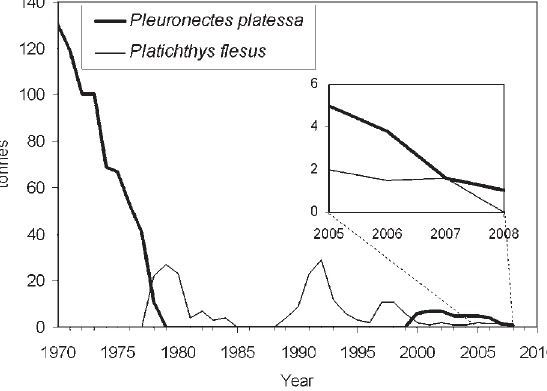
Fig. 1. – French catches of Platichtys flesus and Pleuronectes platessa in the gulf of Lions as reported to the FAO (FAO-GFCM